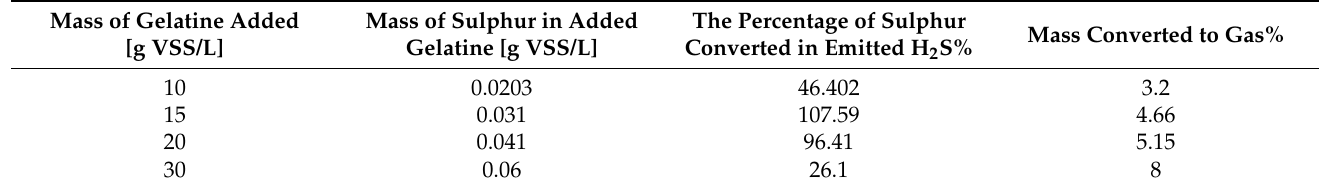
Table 3. Sulphur added with gelatine in samples and the ratio of sulphur converted in emitted hydrogen sulphide % and